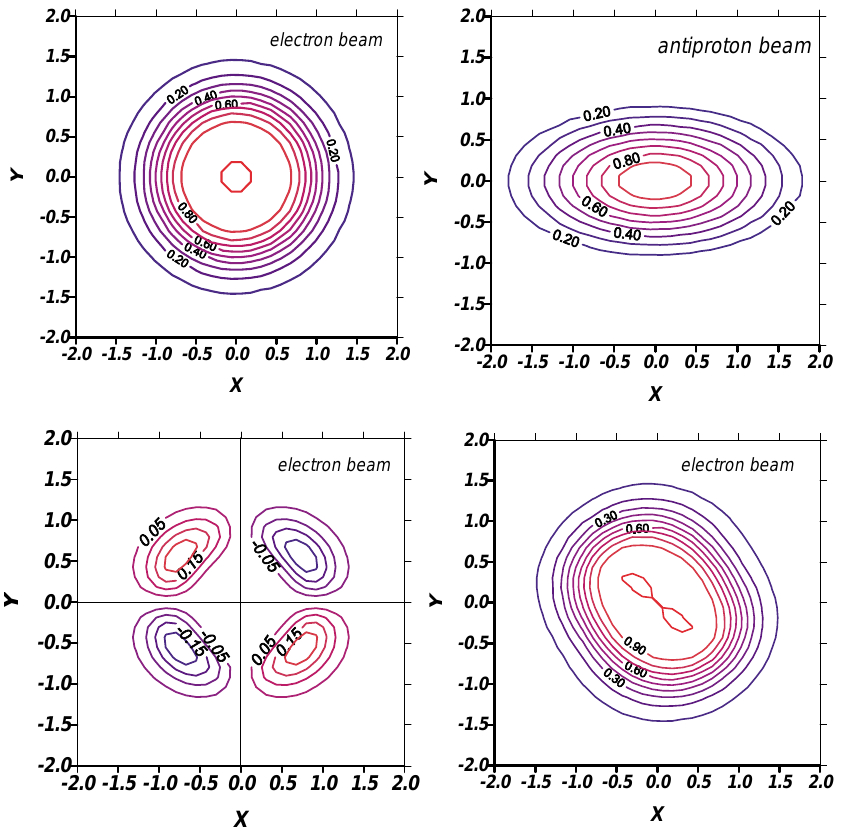
FIG. 11. (Color) Contour plots of original electron density (top left), antiproton density (top right), change of the electron density due to interaction with antiproton space charge (bottom left), and resulting electron density (bottom right). x and y coordinates are given in units of s x